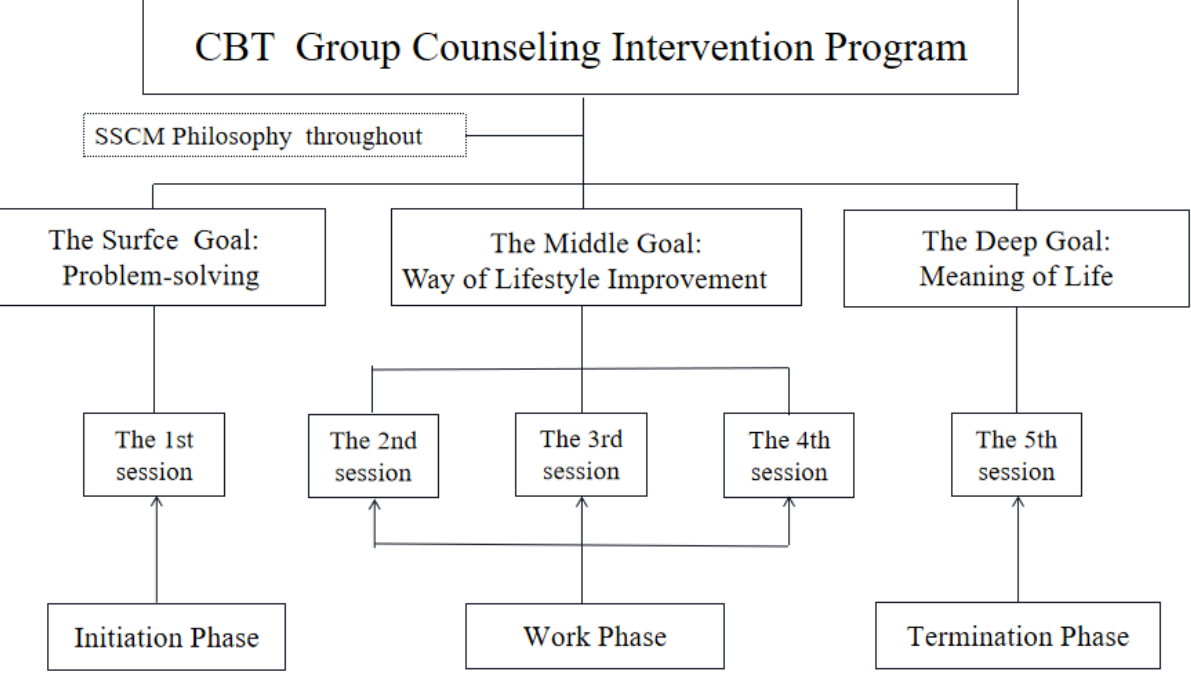
Figure 2. Conceptual diagram of the intervention program.